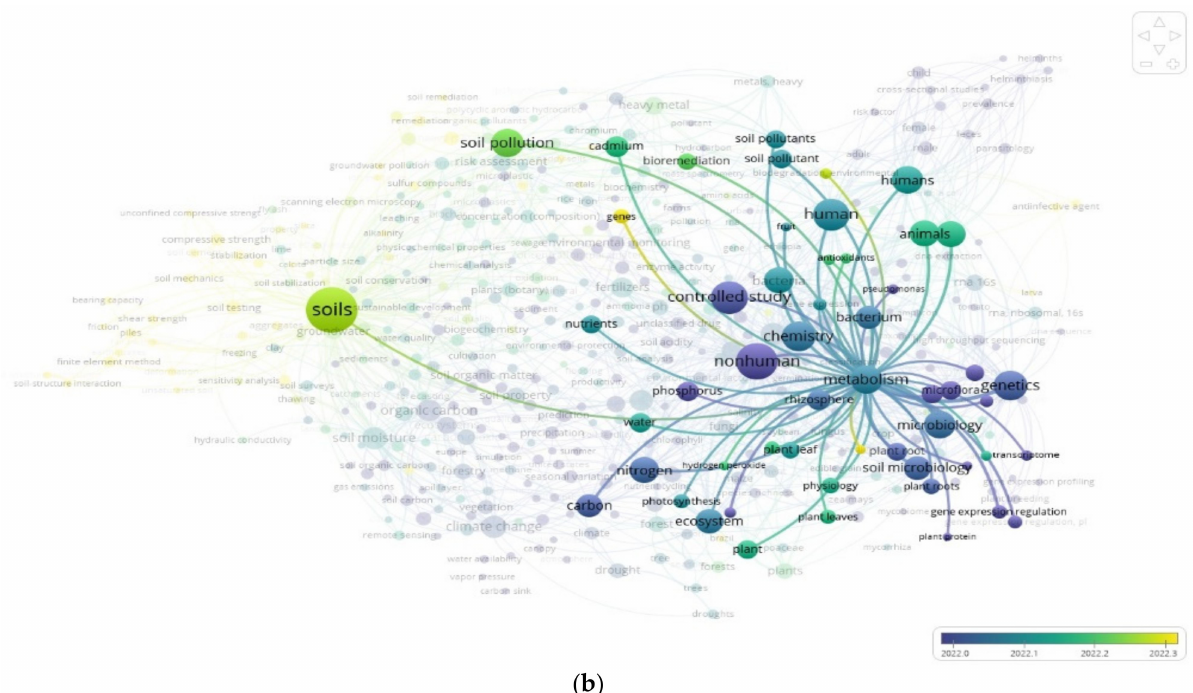
Figure 2. Analyzing Scopus soil results with the VOSviewer. The soil ( a ) and the metabolism ( b ) paradigm. ( a ) Soils are associated with: Microbial community, Metabolism, Bacteria, Nitrogen, Carbon, Climate change and human (purple circles) Soil pollution, Cadmium, Heavy metal, Biore- mentation (green circles). ( b ) Metabolism is associated with: Chemistry, Metabolism, Microbiology, Bacteria, Human, Animals, Rhizosphere, Water, Nutrients, (green circles) Soil Microbiology, Nitrogen, Carbon, Plant roots (purple